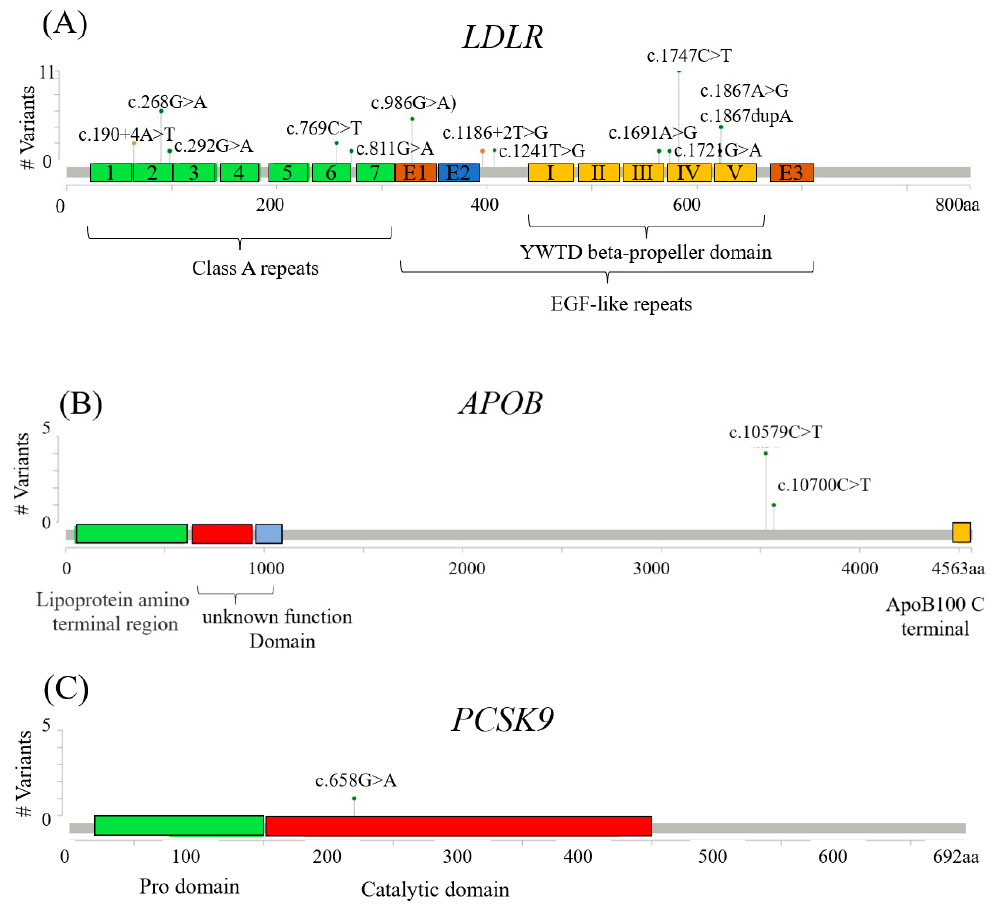
Figure 1. Lollipop plot showing the identified CAD subjects with FH variants relative to the schematic representation of the ( A ) LDLR , ( B ) APOB , and ( C ) PCSK9 genes by the Mutation Mapper. The gray bar represents the amino acid positions (aa). The FH variant position is indicated with a lollipop circle, and the length of the line indicates the patient number of variants detected at that position. The vertical axis shows the frequency of the appearance of each variant. The colored boxes are specific functional domains.